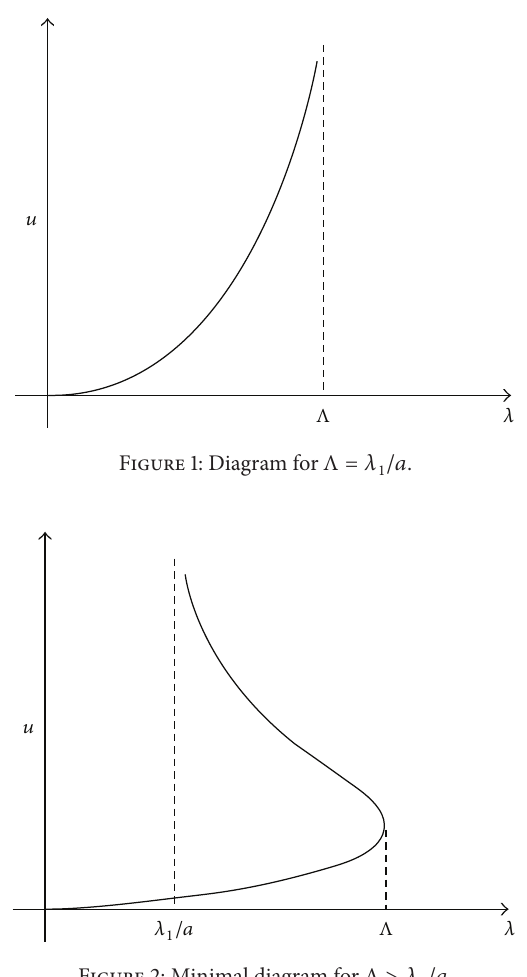
Figure 2: Minimal diagram for Λ > 𝜆 1 /𝑎